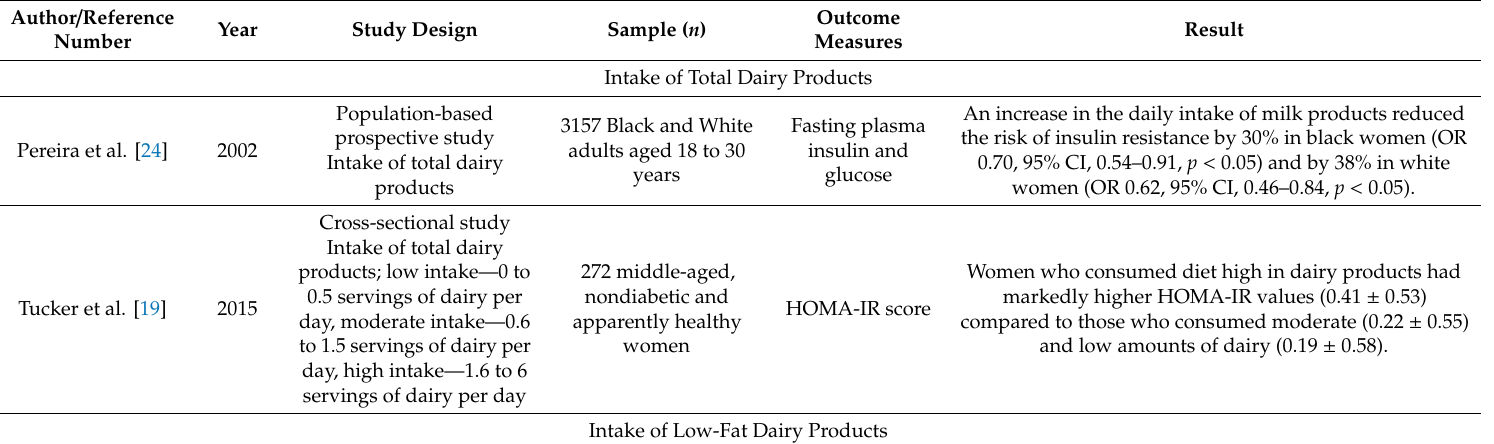
Table 1. The influence of dairy product consumption on insulin resistance in